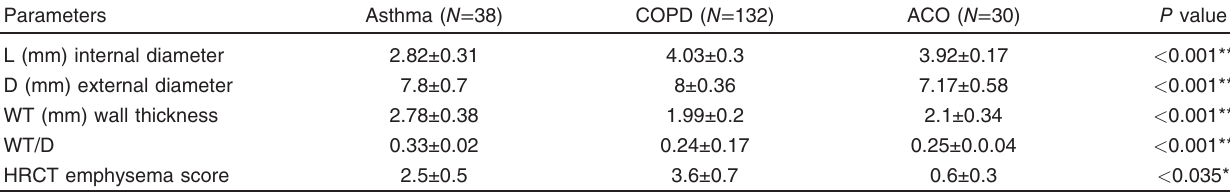
Table 4 Comparison of airway dimensions assessed in HRCT among the studied groups